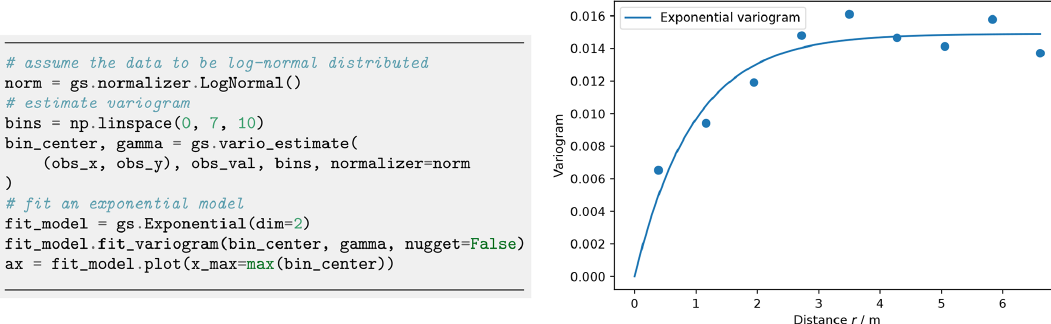
Figure 28. Variogram estimation and resulting experimental (dots) and fitted variogram γ (line) of the Herten aquifer